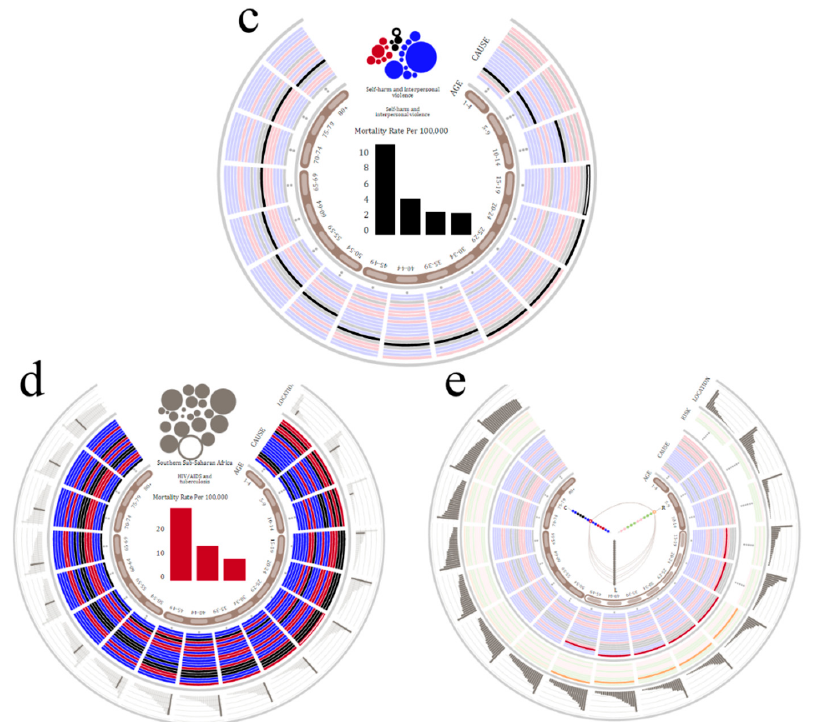
Figure 7. ( a ) Expanded cause track; ( b ) filtered to emphasize the self-harm and interpersonal violence cluster; ( c ) drilled to show the breakdown of the self-harm and interpersonal violence cluster for ages 15–19; ( d ) filtered to emphasize southern sub-Saharan Africa location-cluster and drilled to show the HIV/AIDS&TB cluster for ages 25–29; ( e ) linked to highlight relationship between HIV/AIDS & TB and the physiological risks for ages 15–49.